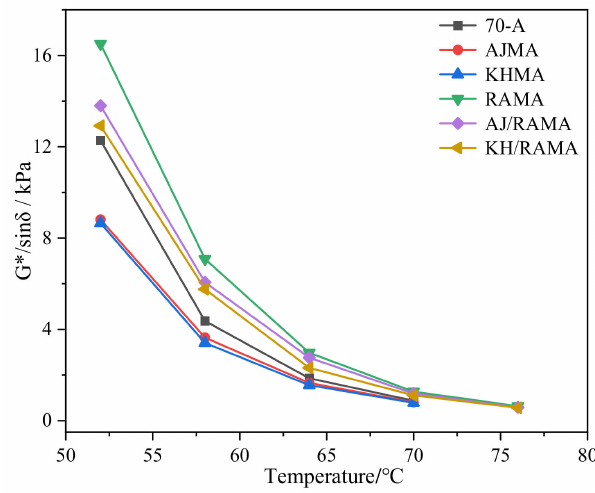
Figure 4. High-temperature performance of six groups of